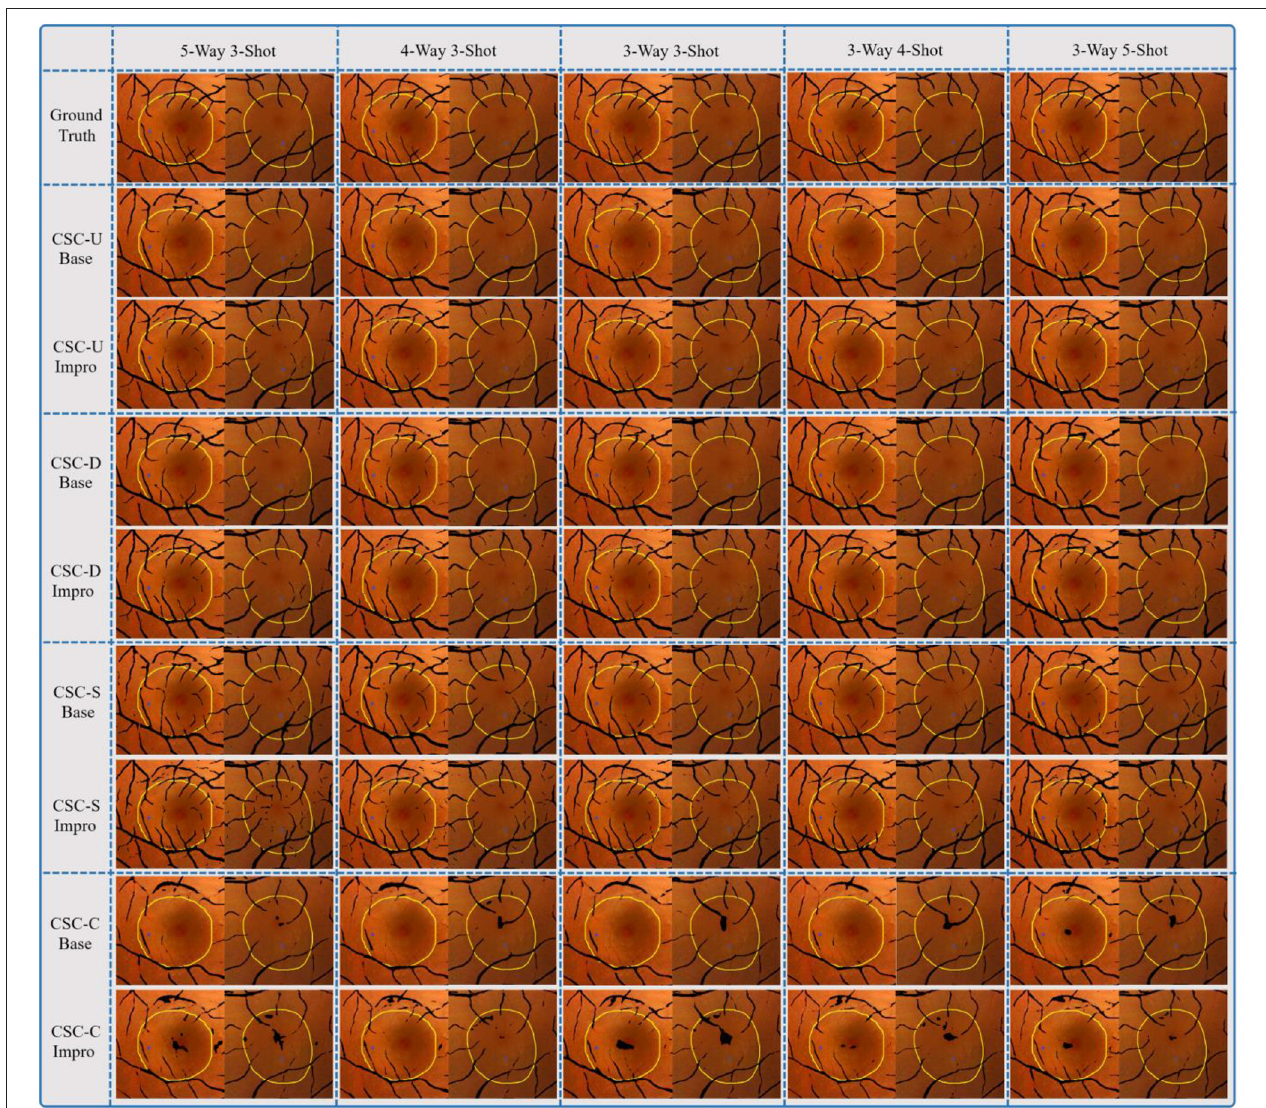
FIGURE 14 | Comparison of the single model and the integrated framework on practical